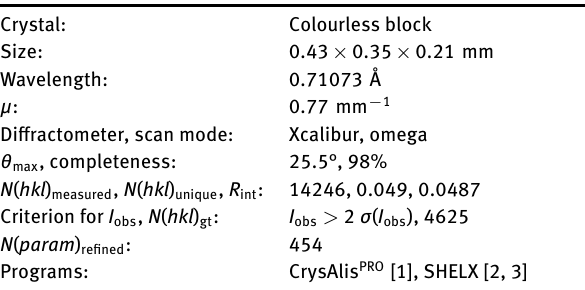
Table 1: Data collection and